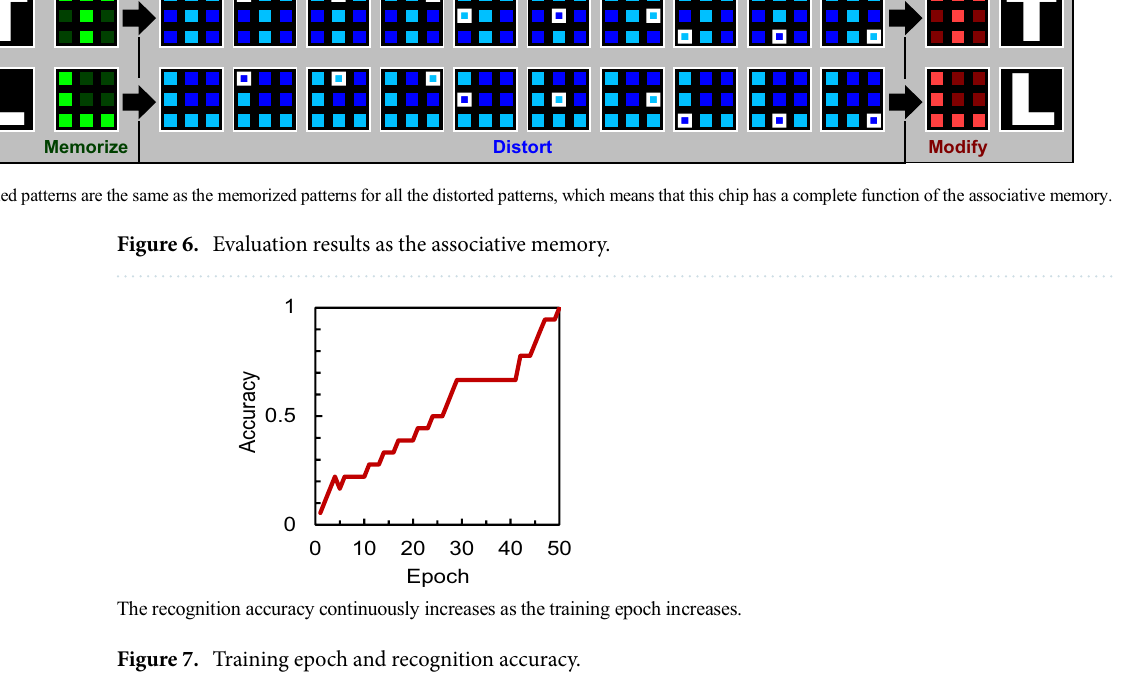
Figure 7. Training epoch and recognition